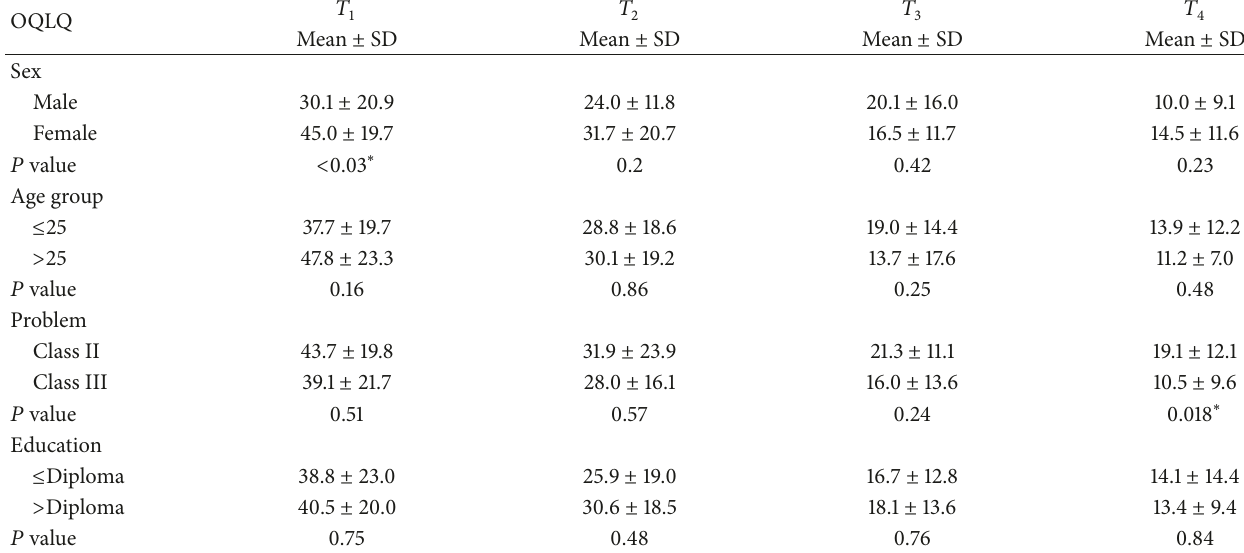
Table 3: Mean OQLQ scores of the sample based on demographic characteristics and phase of treatment.